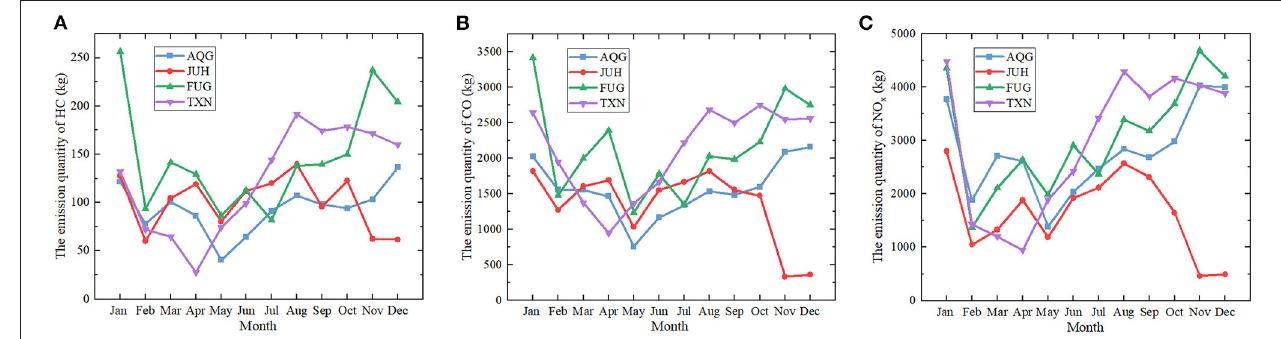
FIGURE 6 | The monthly variation of the air pollutants at 4 airports (except for HFE) in Anhui province, 2020. (A) The emission quantity of HC in kilograms (B) The emission quantity of CO in kilograms (C) The emission quantity of NO x in kilograms. AQG, Anqing Tianzhushan Airport; JUH, Chizhou Jiuhuashan Airport; FUG, Fuyang Xiguan Airport; TXN, Huangshan Tunxi Airport.